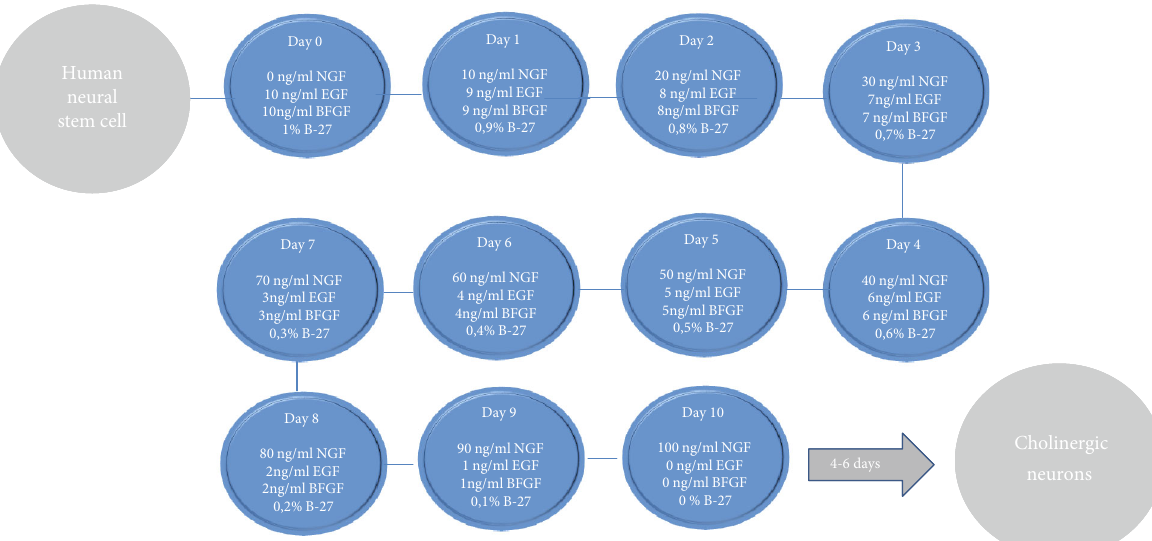
Figure 1: Flow chart of sequential procedure used to produce cholinergic cells derived from human neural stem cells in adherent culture. The protocol involves daily medium change with increasing concentration of NGF and decreasing concentration of EGF, bFGF, and B-27. The medium on day 10 was kept constant for the next four days. The protocol is previously described by